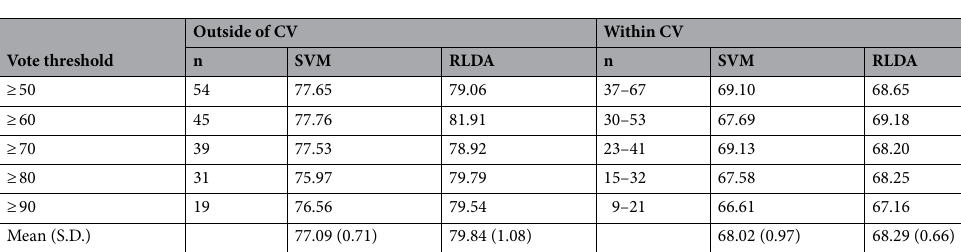
Table 2. Classification accuracies of the actual EEG data. Two feature selection approaches (outside of CV and within CV) were tested using two different classifiers (SVM and RLDA, unit: %) with respect to the different vote thresholds (number of selected features). n* number of selected features, S.D standard deviation, SVM support vector machine, RLDA regularized linear discriminant analysis.